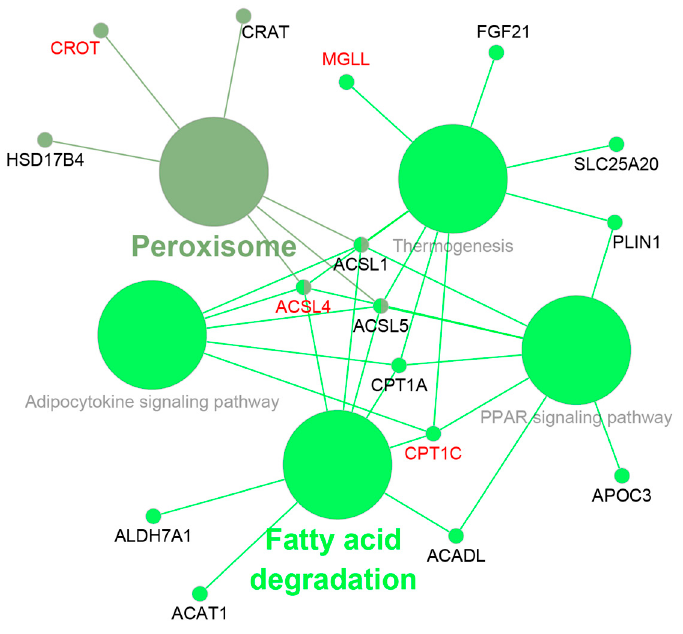
Figure 4. ClueGo analysis of fat-metabolism-related genes. The red represents the up-regulated genes, and the black represents the down-regulated genes.